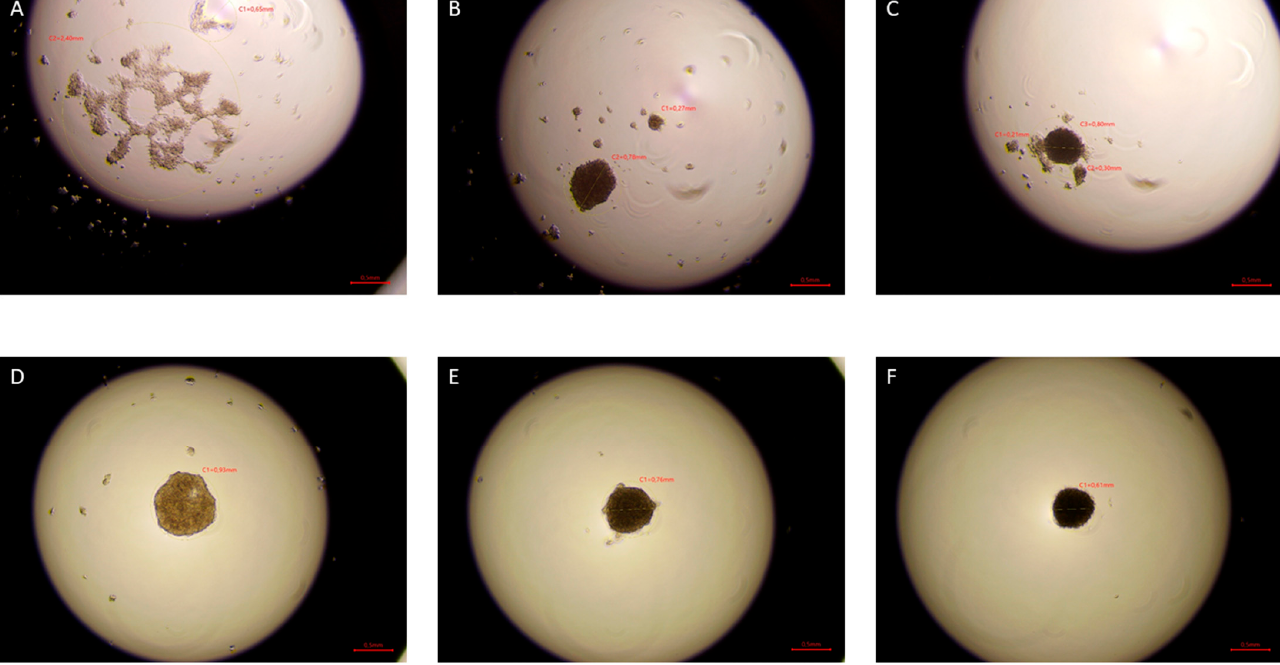
Figure 8. 786-O cells in hanging drop culture. ( A – C ) show 786-O cells from the control group 24, 48, and 72 h from the start of the culture, respectively. ( D – F ) show 786-O cells exposed to 4.5 mT, 50 Hz EMF 24, 48, and 72 h from cultivation, respectively. Pictures taken with the Delta-Optical IB-100 microscope, 4× magnification.